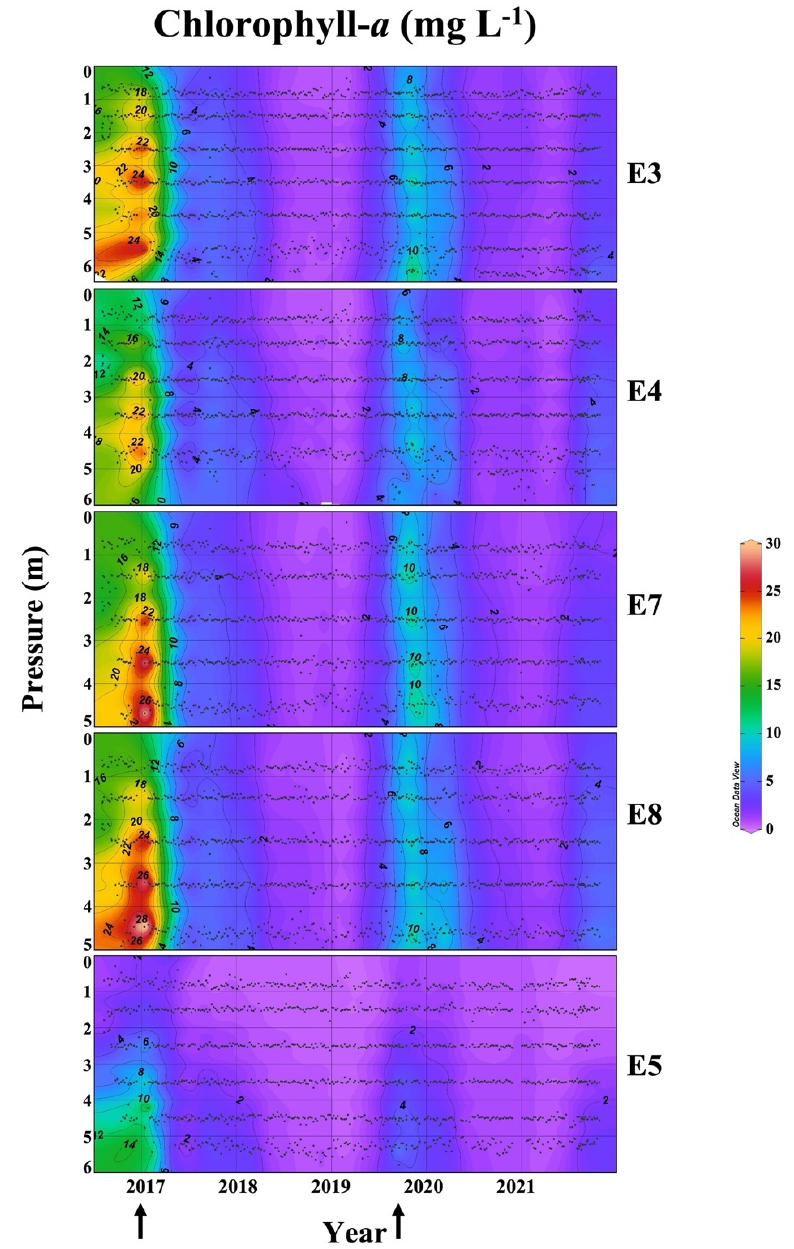
Figure 6. Temporal evolution of chlorophyll- a at stations E3, E4, E7, E8, and E5 from August 2016 to October 2021. The vertical arrows indicate when the two DANA events occurred (December 2016 and September 2019, respectively).